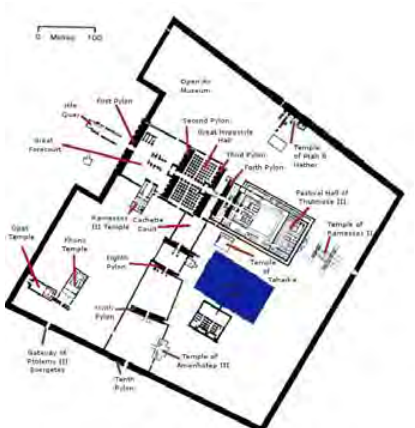
Figure 5. Map of Karnak, showing major temple complexes and sacred crescent lake of Mut